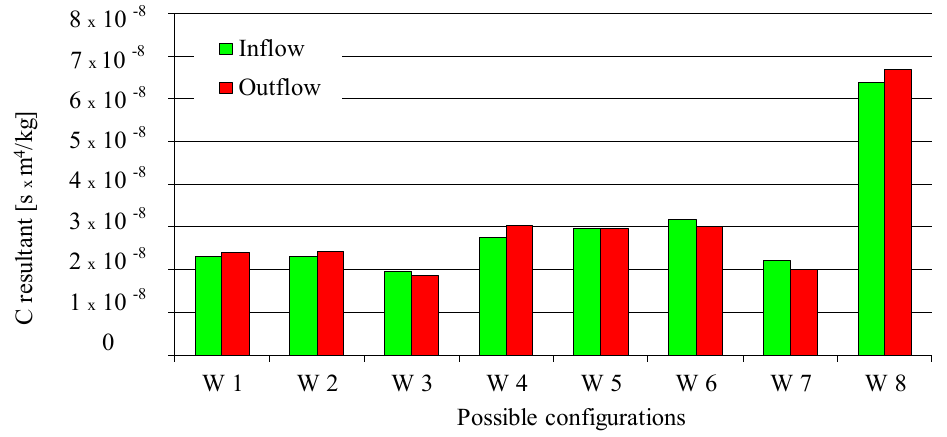
Figure 13. The value of C sound conductivity as a function of the trigger system variant.